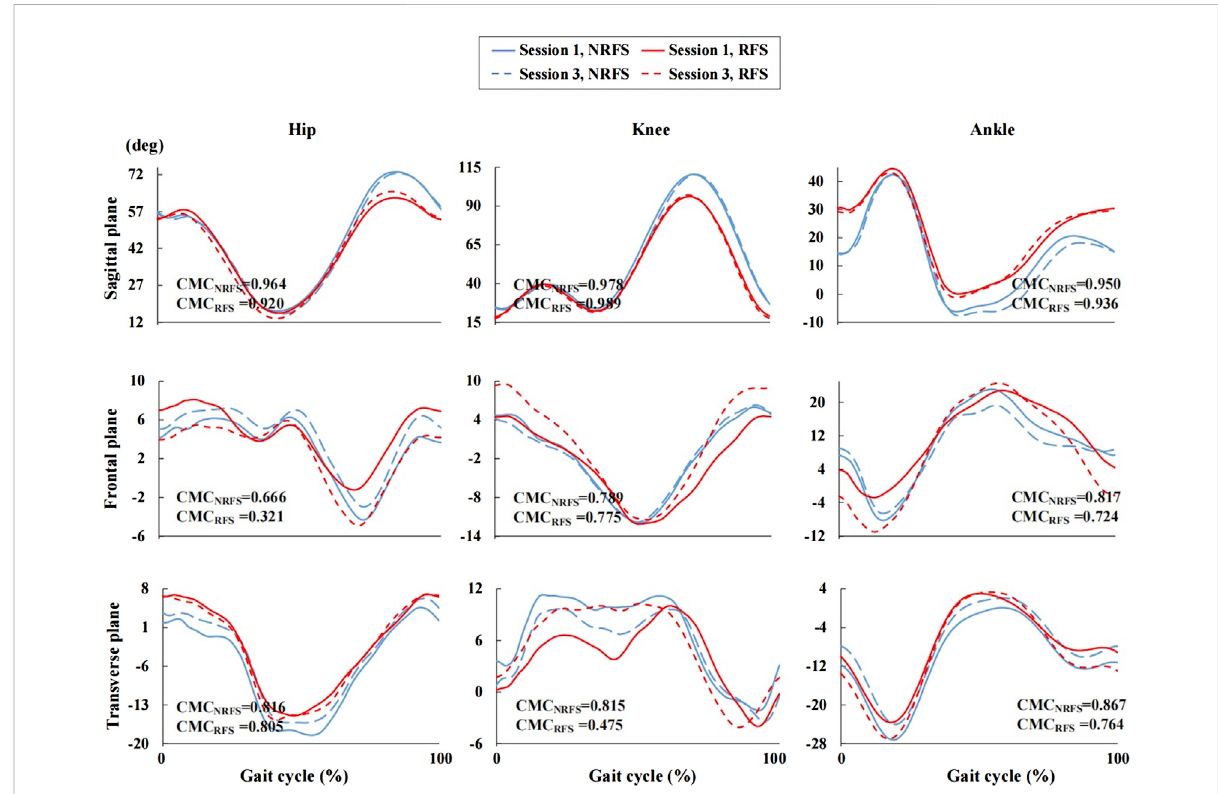
FIGURE 7 Joint angle waveforms during gait cycle measured by the inertial measurement units in session 1 and session 3. NRFS non-rearfoot strike pattern; RFSrearfootstrikepattern;CMC NRFS thecoef fi cientofmultiplecorrelationinNRFSrunners;CMC RFS thecoef fi